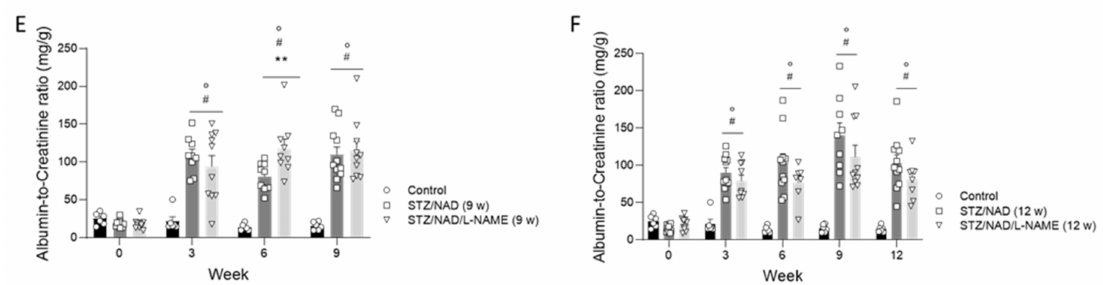
Figure 3. Serum creatinine ( A , B ), creatinine clearance ( C , D ), and urinary albumin-to-creatinine ratio ( E , F ) in STZ/NAD- and STZ/NAD/L-NAME rats for a period of 9 or 12 weeks. Data are presented as mean ± SEM. * p < 0.05 vs. STZ/NAD, ** p < 0.01 vs. STZ/NAD, # p < 0.05 vs. control, and ◦ p < 0.05 vs. week 0.